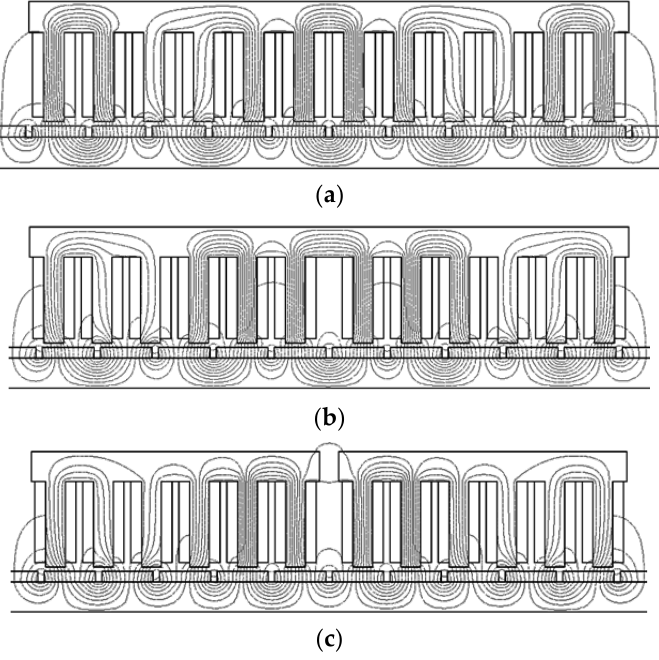
Figure 3. Flux line comparison: ( a ) Model 1: conventional design; ( b ) Model 2: proposed design; ( c ) Model 3: separated section design.